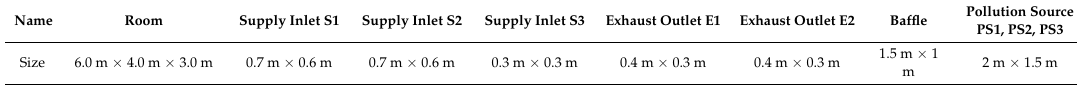
Figure 7. Physical Model II. Table 4. Physical parameters of Model II.